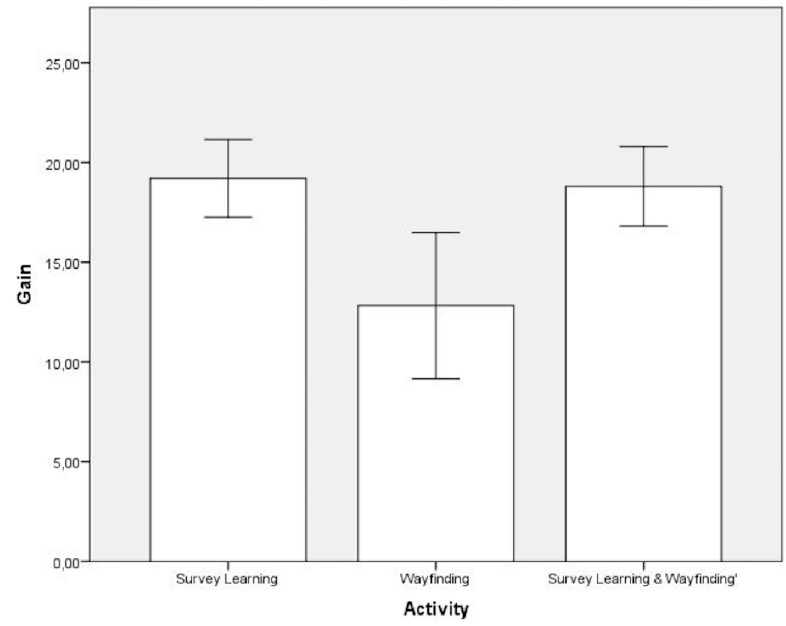
Figure 3. Mean gains as a function of activity with a 95% confidence interval.